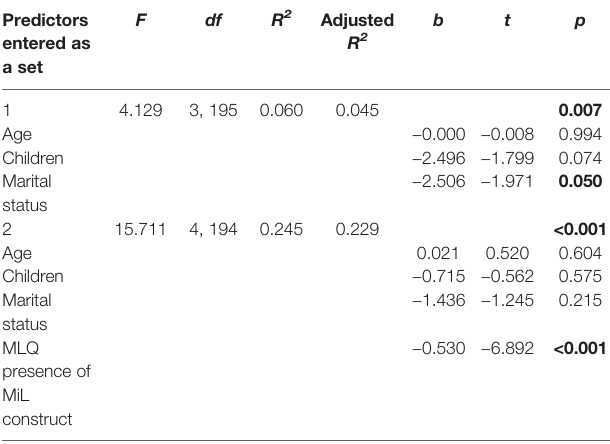
TABLE 2 | Two-step hierarchical multiple regression equation with sociodemographic variables and presence of Meaning in Life (MiL) construct predicting suicidal ideation ( N =